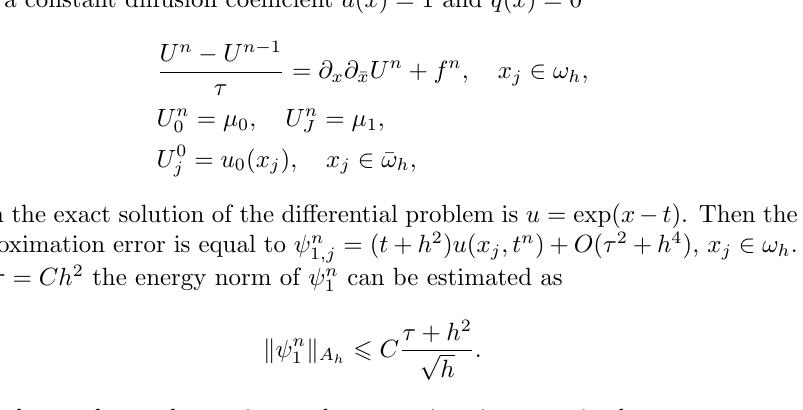
Table 1. Results of computational experiments: analysis of approximation error ψ n τ = h h = 0 . 02 h = 0 .